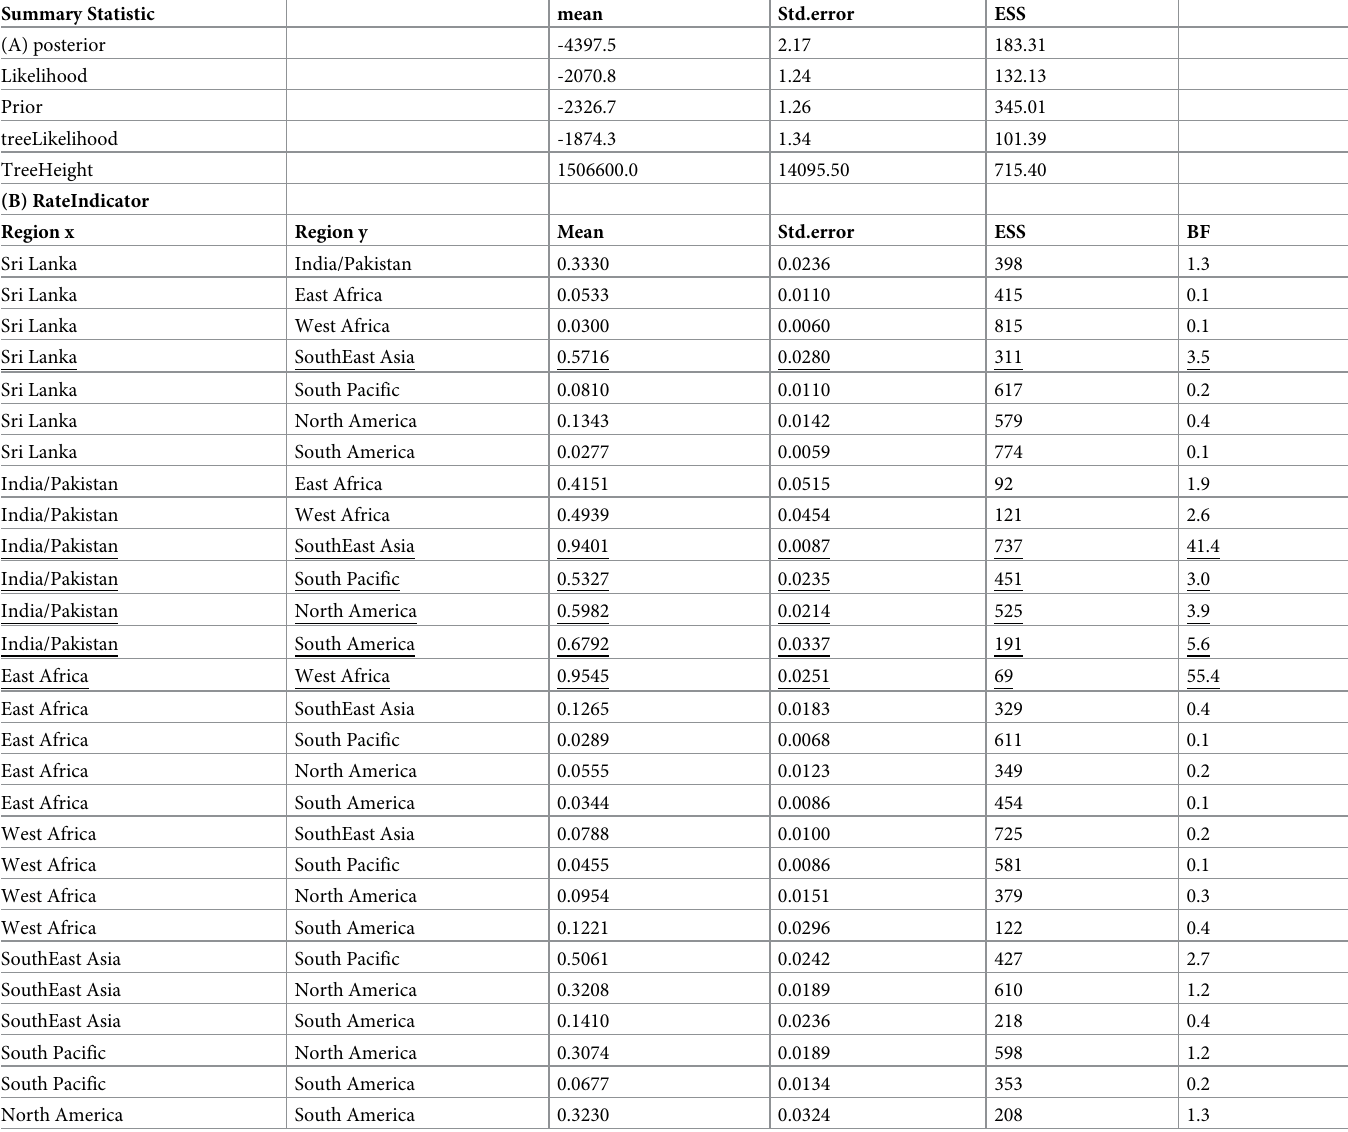
Table 3. A) Tracer analysis of the posterior probability, likelihood, Prior probability, tree likelihood and average tree height. B) Tracer analysis of posterior probability that the migration rate ( rateIndicator ) is positive between a pair of geographic regions x and y. Summary